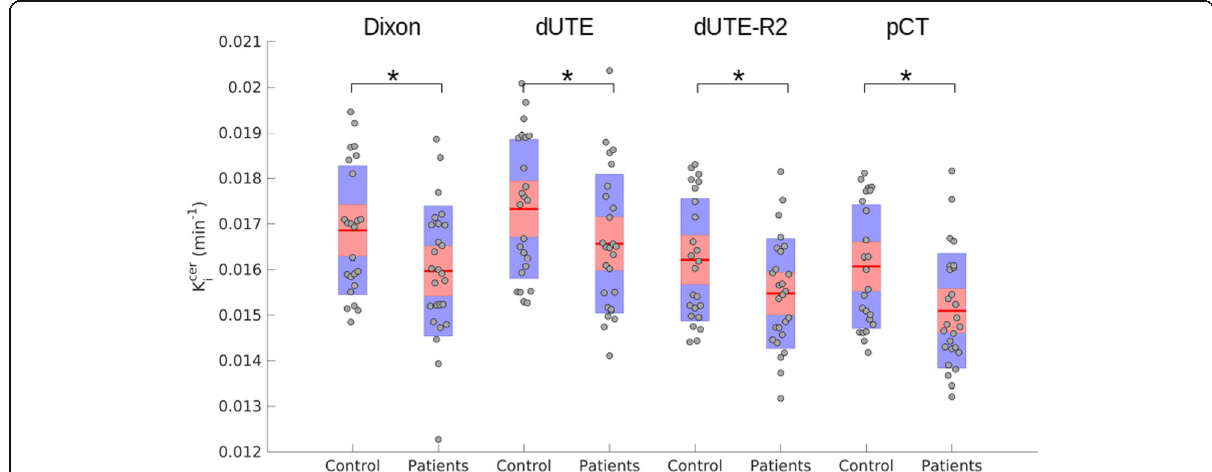
Fig. 7 K i cer values measured in the striatum region for each subject using all the μ -maps, separated by healthy controls and patients. The statistical significance measured between groups for each μ -map is shown as “ * ” for p <